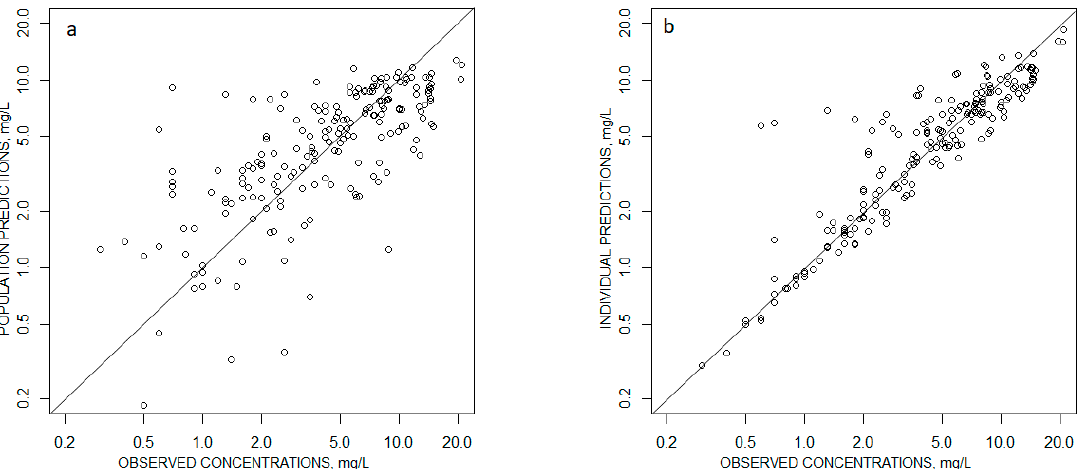
Figure 1. Goodness of fit curves representing ( a ) the Population Predictions vs observed concentrations and ( b ) the individual predictions vs observations. Solid diagonal line: x = y line.